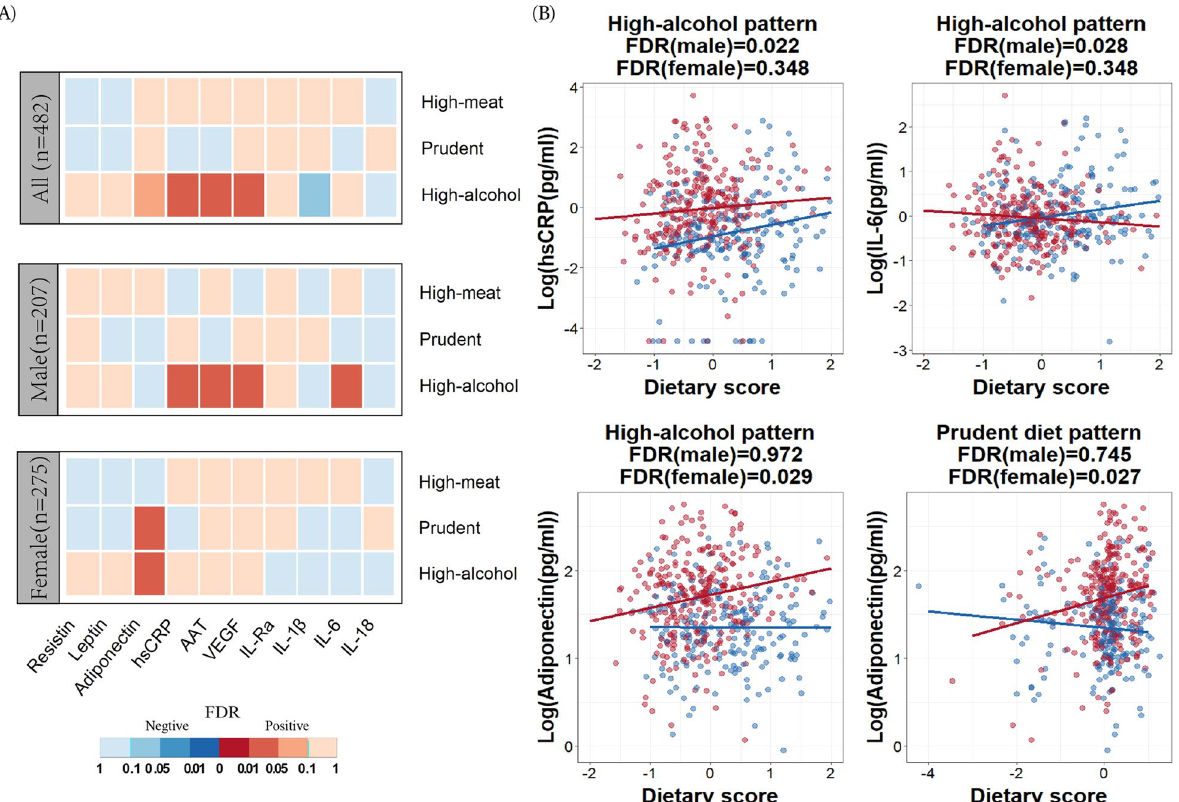
Figure 2. Association between scores of dietary patterns and cytokines concentration. ( A ) The P values (FDR corrected per column) of the regression between each dietary pattern and circulating inflammatory cytokines by log transformation. Red in figure legend indicates an FDR with positive correlation and blue indicates FDR with negative correlation. ( B ) Scatterplots show the effect of dietary pattern on cytokines with significant correlation. Blue dots and lines indicate males, red dots and lines indicate